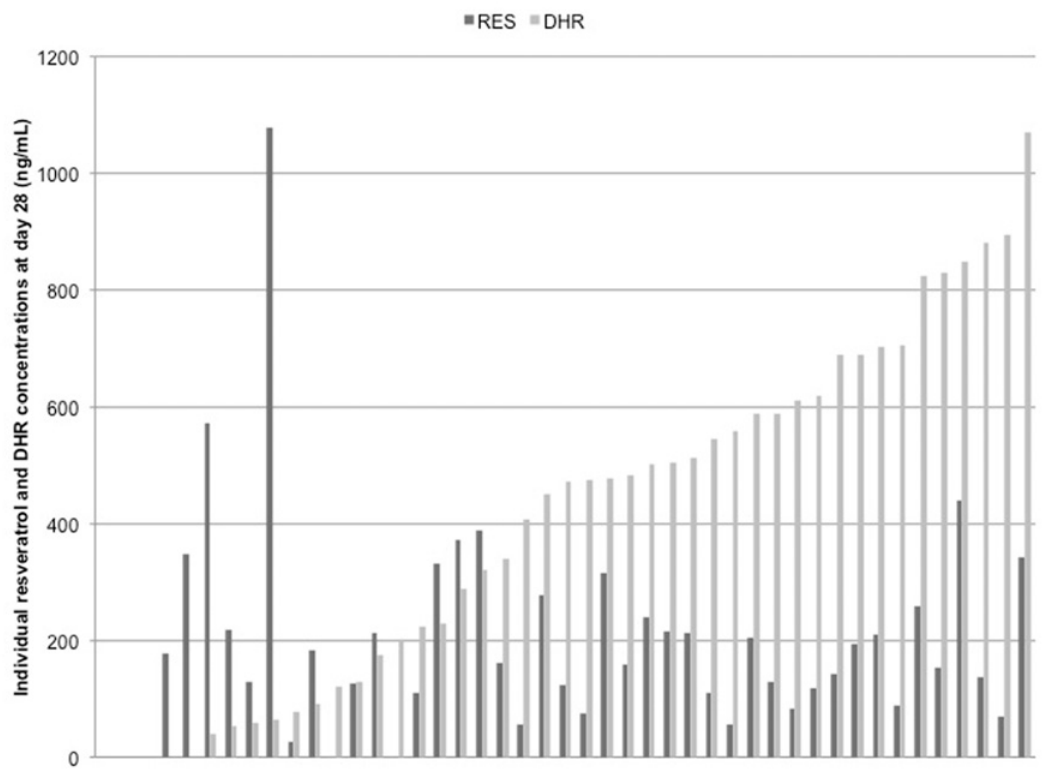
Fig 2. Individual total resveratrol (RES) and total dihydroresveratrol (DHR) concentrations at day 28.